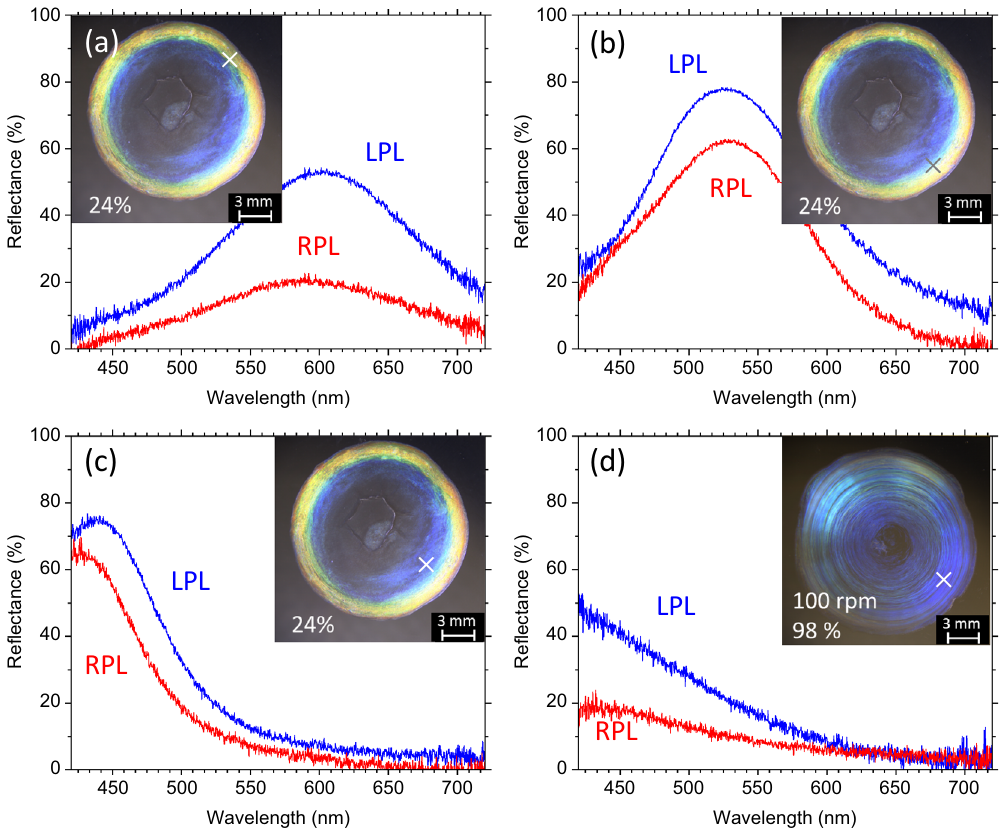
Figure 8. Reflection spectra recorded from points indicated by crosses in the insets under circularly polarized light showing various colors in 7% CNC droplet films dried at ( a ) ‒ ( c ) 24% humidity without orbital shaking and ( d ) 98% humidity while being orbitally shaken at 100 rpm. LPL and RPL are left- and right-handed circularly polarized light,